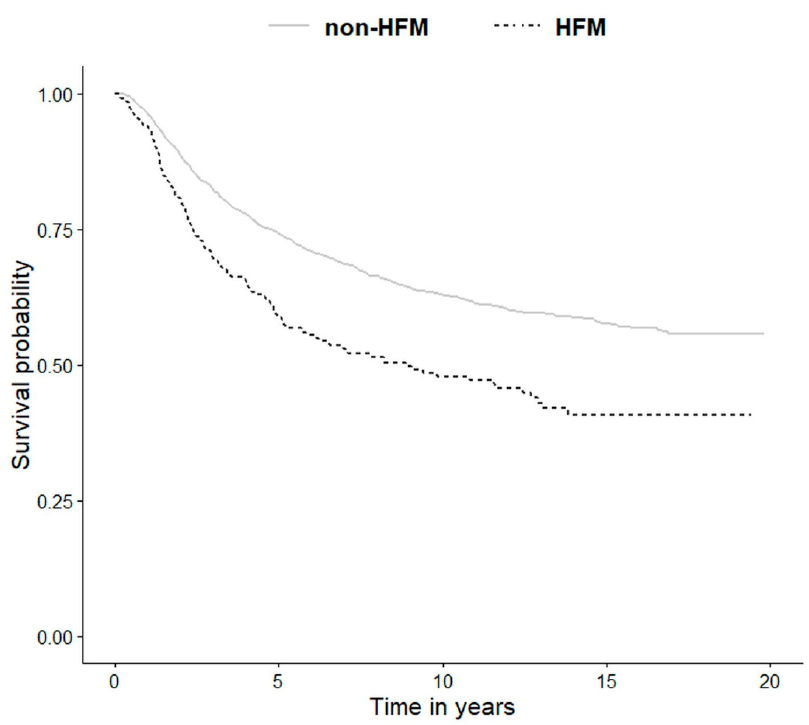
Figure 7. Kaplan–Meier estimation of the OS of non-HFM vs. HFM patients. Legend: HFM—hand and foot melanoma, OS—overall